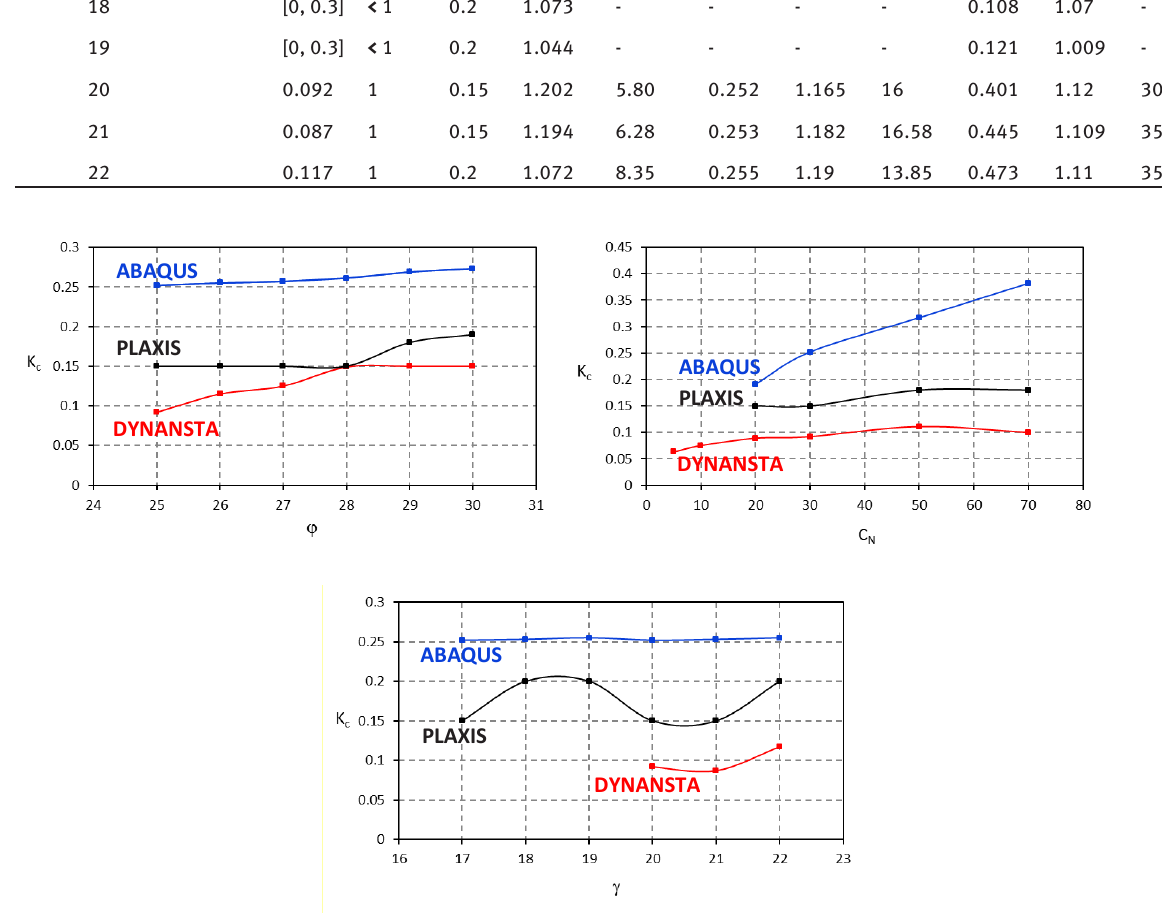
critical state values according to the different Figure 17: K c